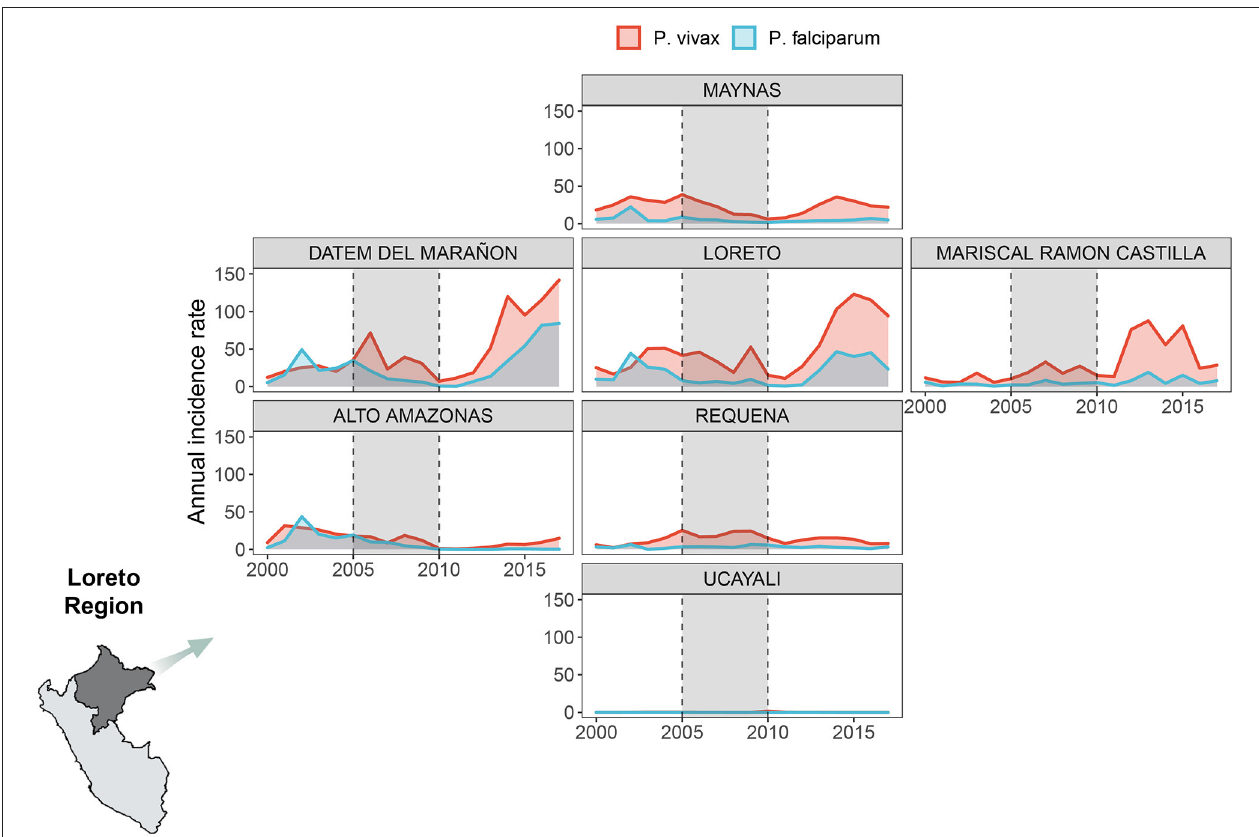
FIGURE 1 | Annual malaria incidence rates variation by parasite species. Annual malaria incidence rates variation due to P. vivax (red) and P. falciparum (light blue) in 7 provinces of Loreto Region between 2000 and 2017. We created our own grid using the geofacet R package to represent the Loreto provinces: Maynas (first row), Datem del Marañon, Loreto, Mariscal Ramon Castilla (second row from left to right), Alto Amazonas, Requena (third row from left to right), Ucayali (fourth row). The period shaded in gray represents the PAMAFRO